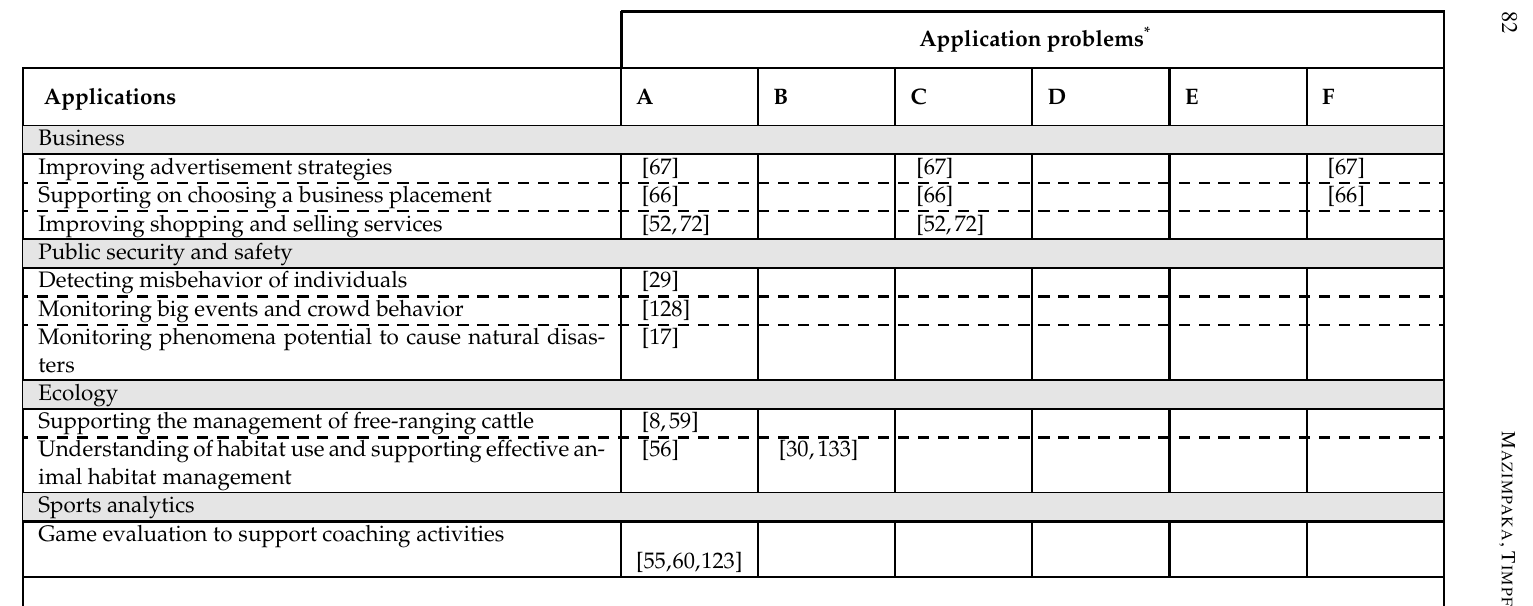
Table 3 (continued): Applications of trajectory data mining and corresponding application